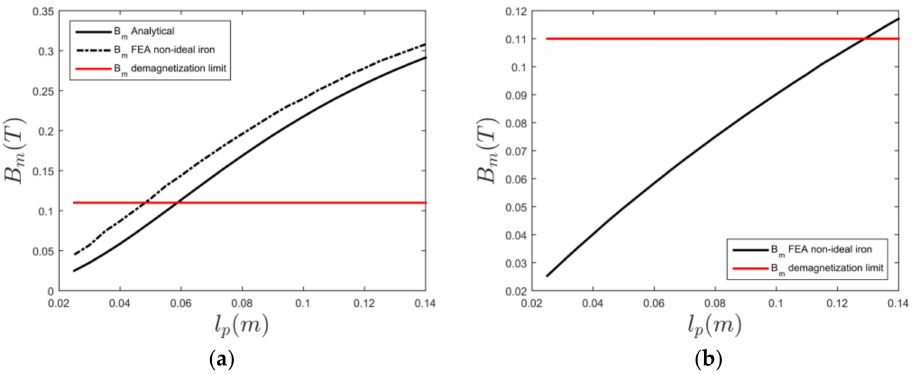
Figure 5. The magnetic flux density inside the magnets for a linear generator, when the translator is inside the stator ( a ) and outside the stator ( b ). The values are from 2D simulations with k = 0.45, δ (cid:48) = 0.003 m, w T = 0.2 m, and µ r,m , and the stator is